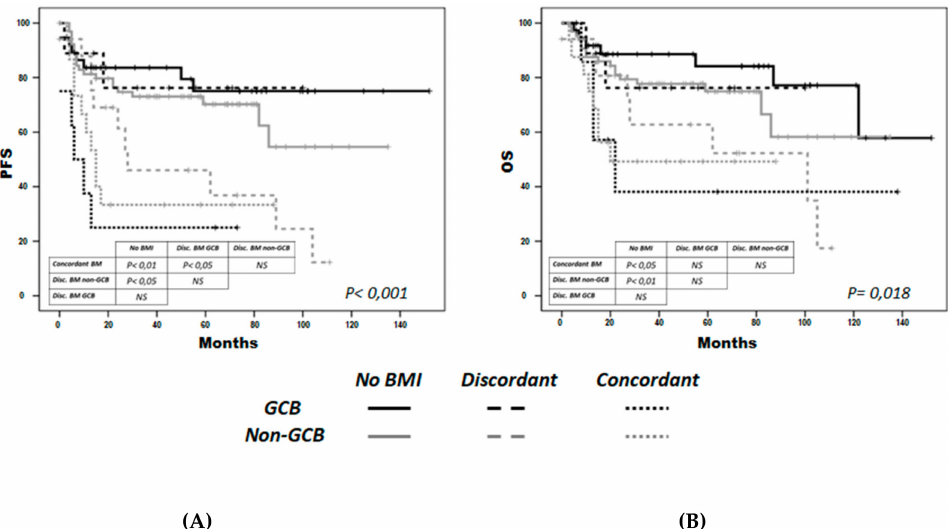
Figure 3. Progression-free survival (PFS) ( A ) and overall survival (OS) ( B ) by bone-marrow infiltration type and cell of origin. Concordant BMI was represented as a dotted line, discordant BMI as a discontinuous line, and the non-infiltrated BMI as continuous line. Black lines represent germinal center B-cell like (GCB), while gray non-GCB DLBCL. ( A ) PFS was significantly decreased in both concordant BMI groups as compared to both non-infiltrated groups, and discordant GCB group ( p < 0.05, all comparisons). PFS was also lower in the discordant non-GCB group than in the non-infiltrated groups ( p < 0.05). ( B ) OS was significantly lower in both concordant groups, and in the discordant non-CGB group, compared with the non-infiltrated groups ( p <